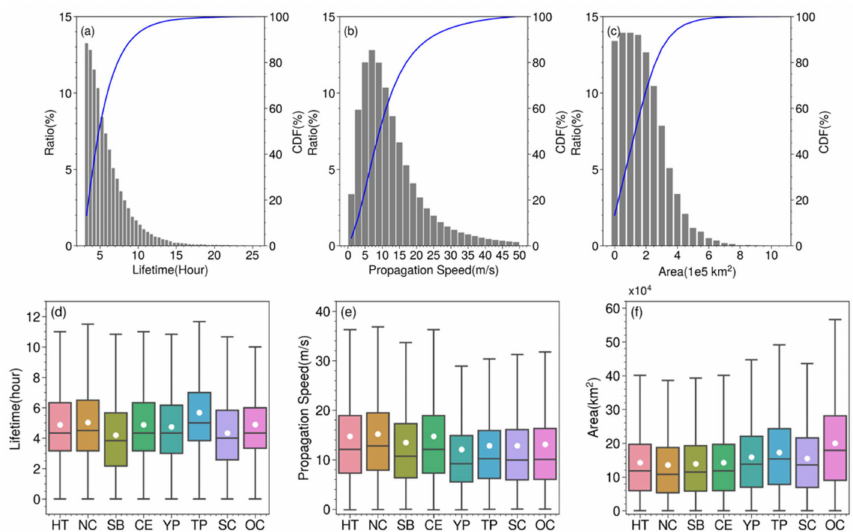
Figure 2. Frequency and cumulative distribution function (CDF, blue solid line) of convective ( a ) lifetime, ( b ) propagation speed, ( c ) areas. The boxplot of ( d ) lifetime ( e ) propagation speed and ( f ) areas of convective systems over Hetao (HT), North China (NC), Sichuan Basin (SB), Central Eastern China (CE), Yunnan-Guizhou Plateau (YP), Tibetan Plateau (TP), South China (SC) and Ocean (OC), respectively. The white circle dot indicates the average value in ( d – f